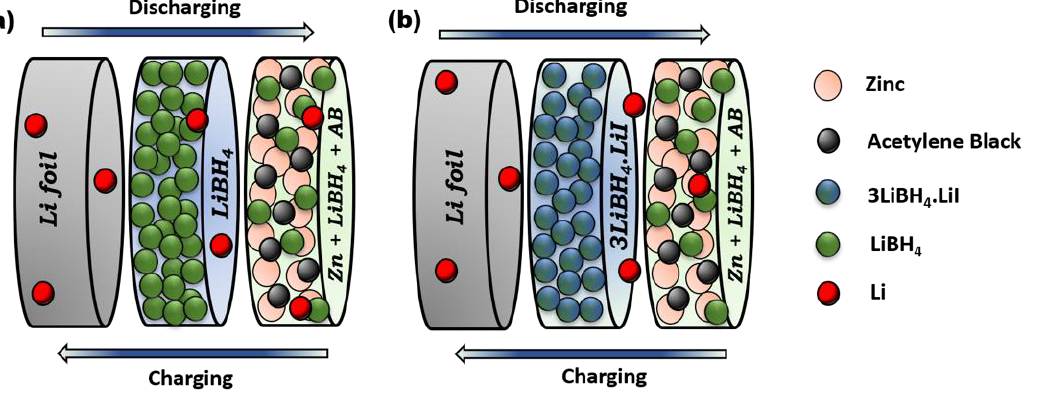
Figure 4. Battery assembly using both electrolyte layers: ( a ) Zn, LiBH 4 , and AB using LiBH 4 electrolytes; and ( b ) Zn, LiBH 4 , and AB using 3LiBH 4 .LiI electrolytes.